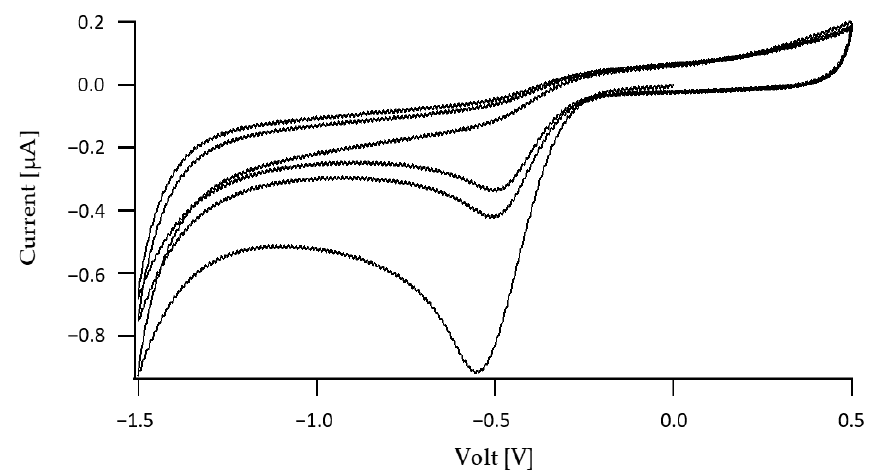
Figure 1. Cyclic voltammetric measurement of rsCMS 1a in dry DMSO at a scan rate of 100 mV/s, three rounds.